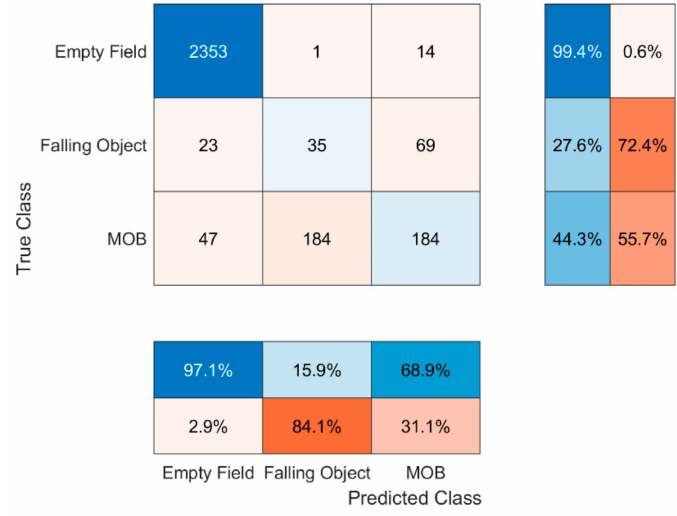
Figure 13. C2 (cid:48) s confusion matrix. Table 5. Comparison of the algorithms’ WMF1 score and